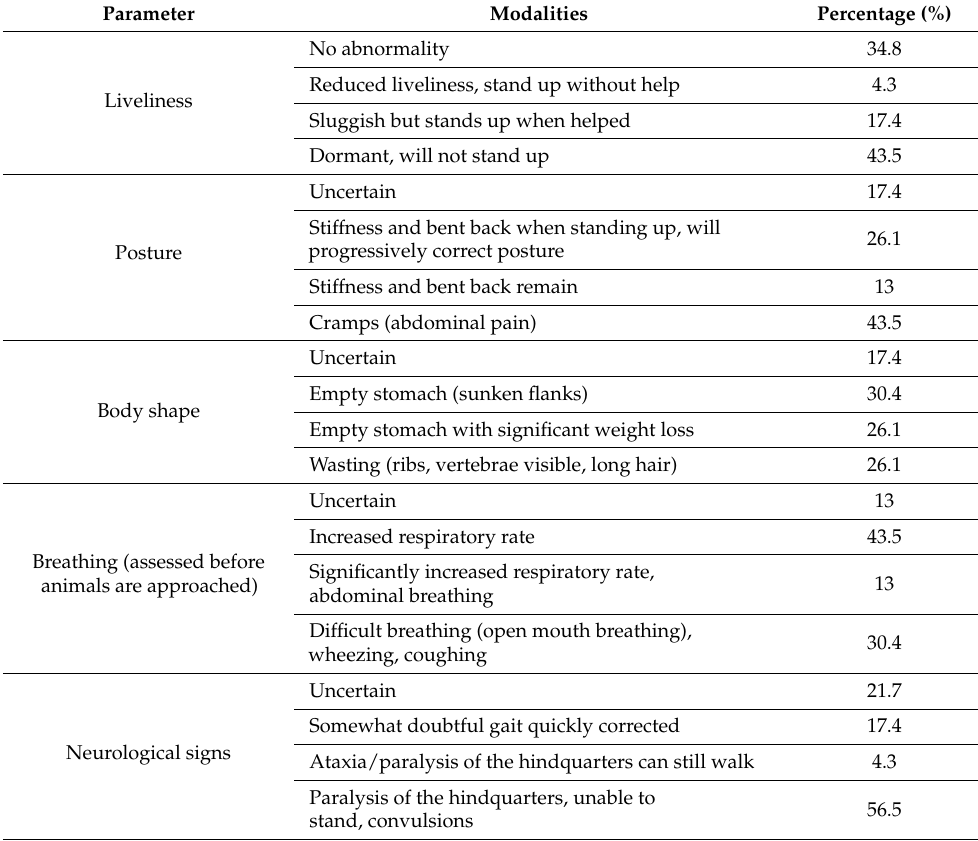
Table 4. Farmer’s view of an actual ASF situation in their